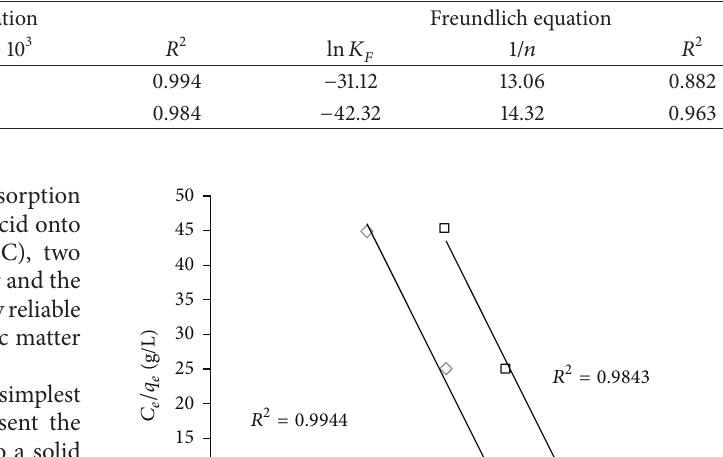
Table 4: Isotherm constants of O.M adsorption onto RBC and RGC samples at 35 ∘ C (particle size: 63 𝜇 m; 𝐶 0 = 491ppm; S/L = 20 g/L; 𝑇 : 35 ∘ C).